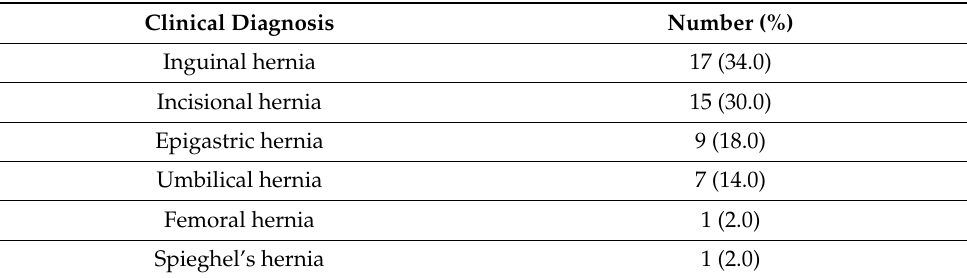
Table 1. Distribution of abdominal hernias in N = 50 study patients.